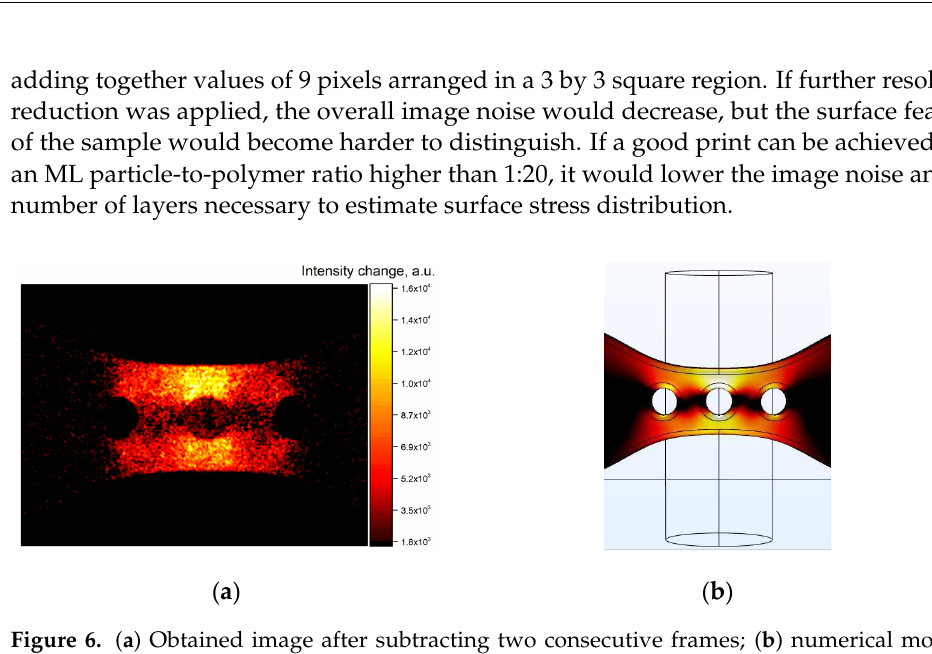
Figure 6. ( a ) Obtained image after subtracting two consecutive frames; ( b ) numerical model of stress distribution.